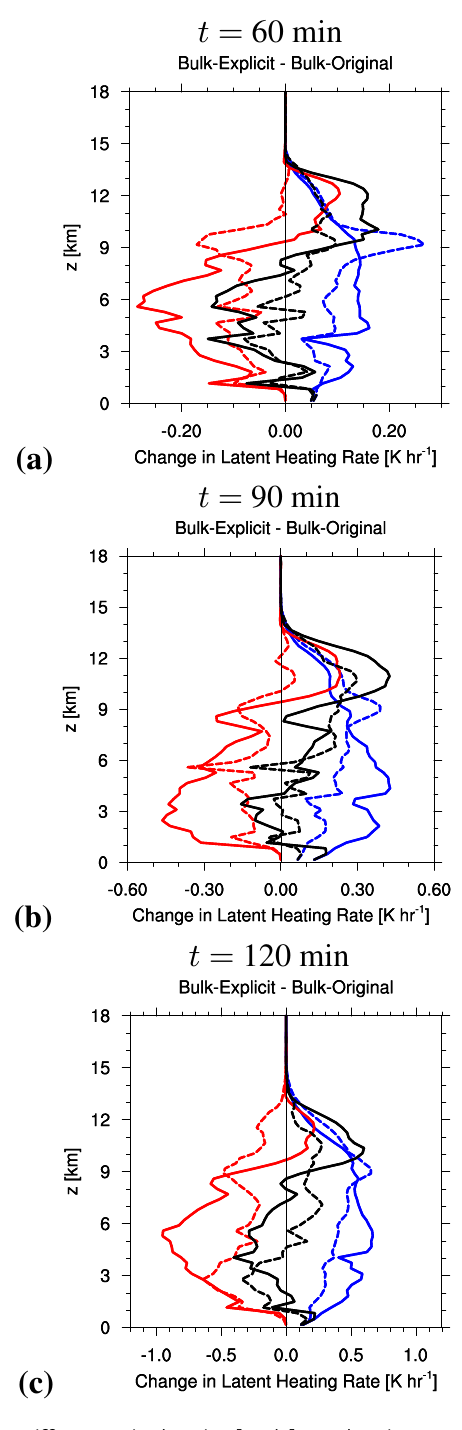
Fig. 11. Differences in the simulated latent heating rates for the